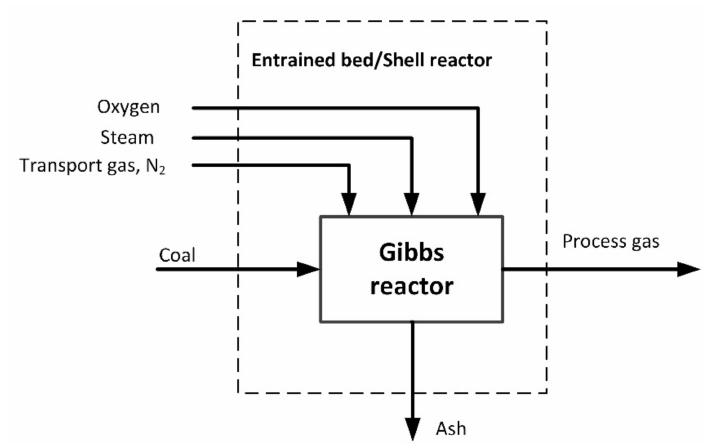
Figure 2. Block diagram for coal gasification in Shell reactor-calculation